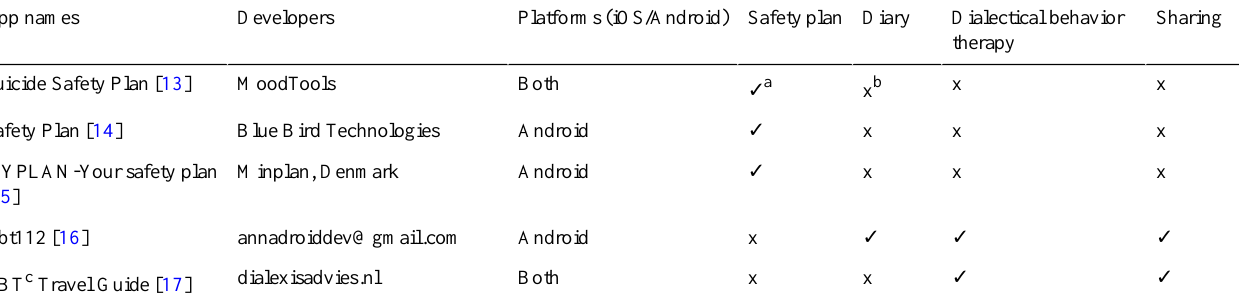
Table 1. Review of existing apps in the area of mental health and suicide